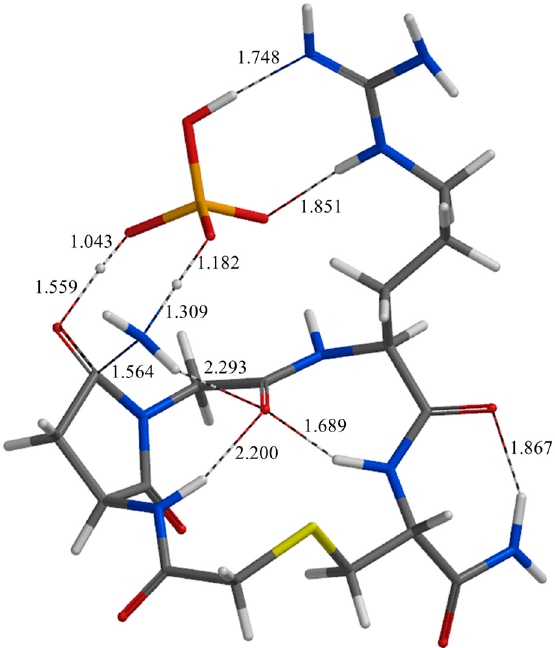
Figure 12. The geometry of TS5 (transition state 5) connecting IC4 (Figure 11) and PC (Figure 13). Selected interatomic distances are shown in Å. Grey: carbon; white: hydrogen; blue: nitrogen; red: oxygen; orange: phosphorus; yellow: sulfur.